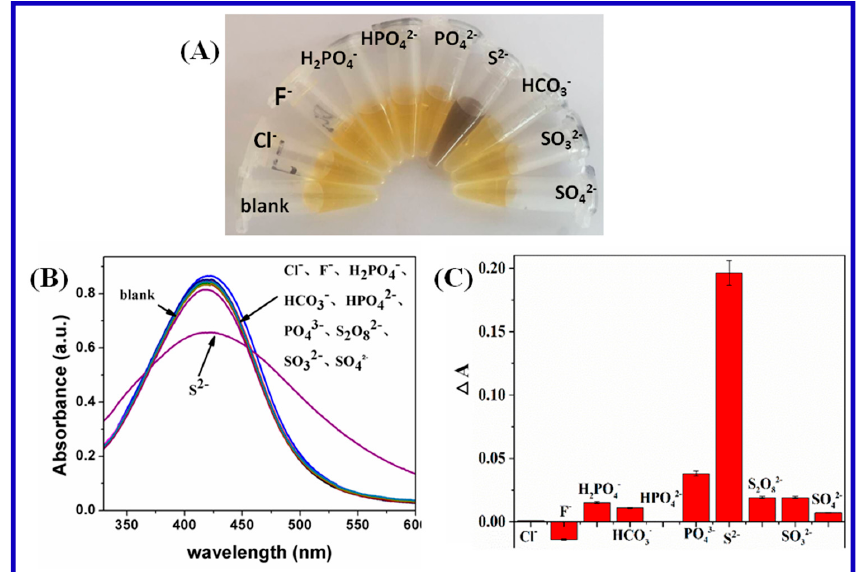
Figure 7. ( A ) Photographic image of color changes of carrageenan-AgNPs after the addition of different anion ions. ( B ) The UV-Vis absorption spectral of AgNPs with different anion ions. ( C ) Relative absorption intensity changes at 425 nm with various anion ions.